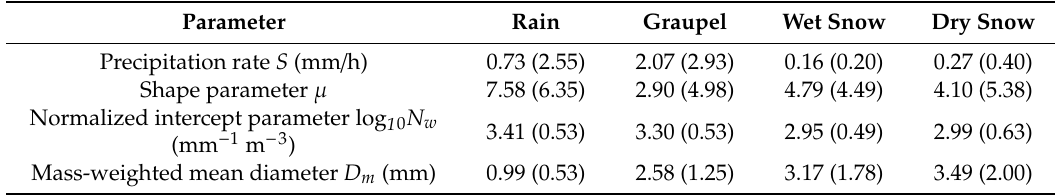
Table 1. The mean (standard deviation) of the four parameters of rain, graupel, wet snow, and dry snow. Parameter Rain Graupel Wet Snow Dry